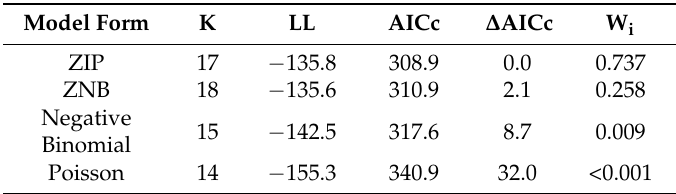
Table 3. Model selection results to determine the appropriate model form for the regeneration of limber pine